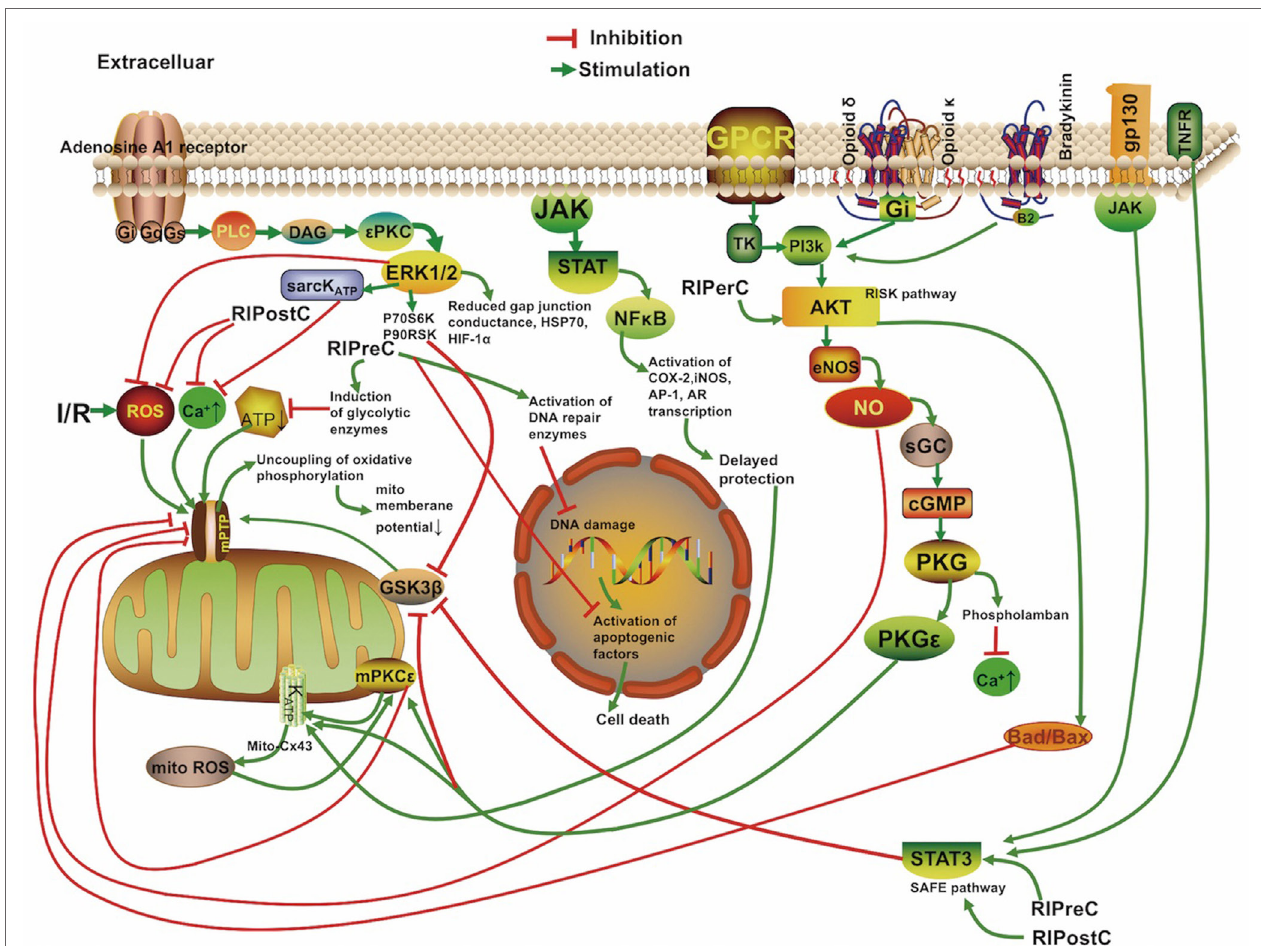
FigURe 2 | Overview of the proposed signaling cascades recruited in the setting of remote ischemic conditioning based on available data. Abbreviations: Akt, protein kinase B; AR, aldose reductase; AP-1, activator protein 1; cGMP, cyclic guanosine monophosphate; COX-2, cyclooxygenase-2; Cx 43, connexin 43; DAG, diacylglycerol; eNOS, endothelial nitric oxide synthase; ERK, extracellular signal regulated kinase; Gs/Gi/q, stimulatory/inhibitory G protein; GPCR, G protein-coupled receptor; gp130, glycoprotein 130; GSK3 β , glycogen synthase kinase 3 β ; HIF-1 α , hypoxia-inducible factor 1 α ; HSP, heat shock protein; IR, ischemia/reperfusion; iNOS, inducible nitric oxide synthase; JAK, Janus kinase; K ATP , ATP-sensitive potassium channel; mPTP, mitochondrial permeability transition pore; Mito, mitochondria; NF κ B, nuclear factor κ B; NO, nitric oxide; P70S6K, p70 ribosomal S6 protein kinase; P90RSK, 90 ribosomal S6 kinase; PI3k, phosphoinositide-3 kinase; PKC, protein kinase C; PKG, protein kinase G; PLC, phospholipase C; RISK, reperfusion injury salvage kinase pathway; ROS, reactive oxygen species; sarcK ATP , sarcolemmal potassium channels; sGC, soluble guanylate cyclase; SAFE, survivor activating factor enhancement; STAT, signal transducer and activator of transcription; TK, tyrosine kinase; TNFR, tumor necrosis factor